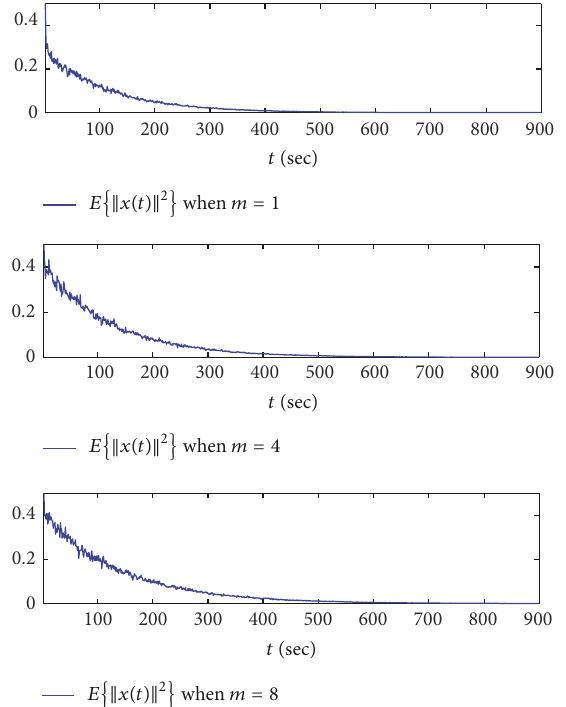
Figure 2: Comparison of mean square stability under different values of 𝑚